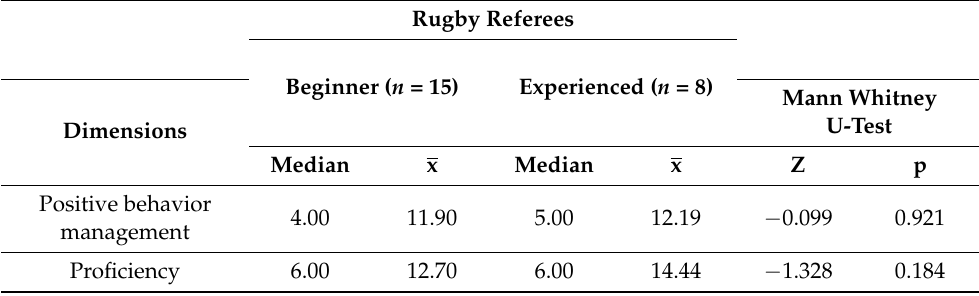
Table 7. Differences in the assessment of the quality of referee–players interactions in positive behavior management and proficiency dimensions between beginner and experienced referees ( n =